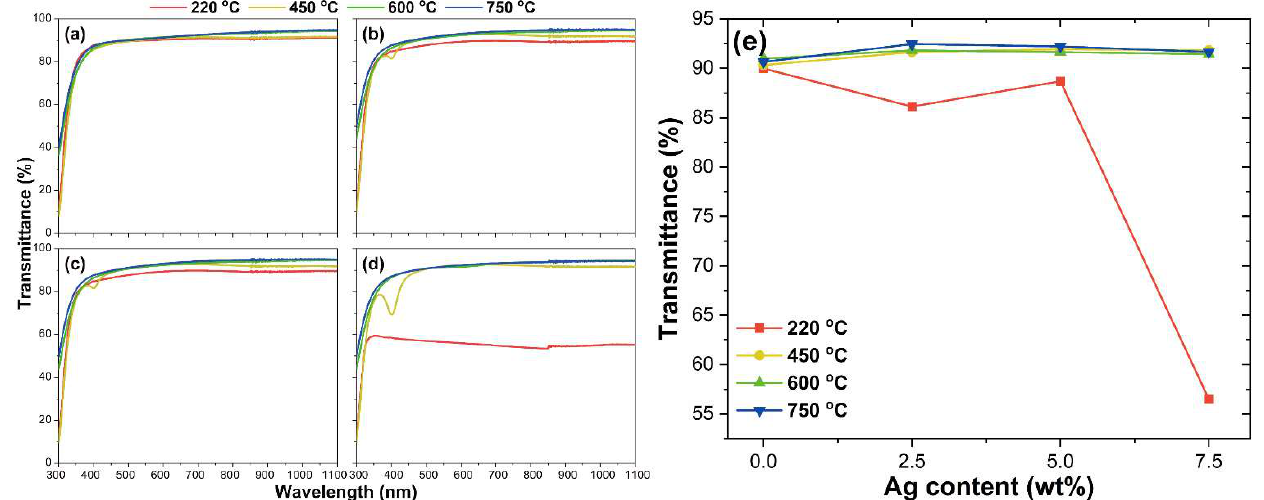
Figure 5. Optical transmittance spectra of ( a ) ITO, ( b ) ITO@Ag (2.5 wt.%), ( c ) ITO@Ag (5.0 wt.%), ( d ) ITO@Ag (7.5 wt.%) thin films, and ( e ) optical transmittance of thin films at 550 nm.